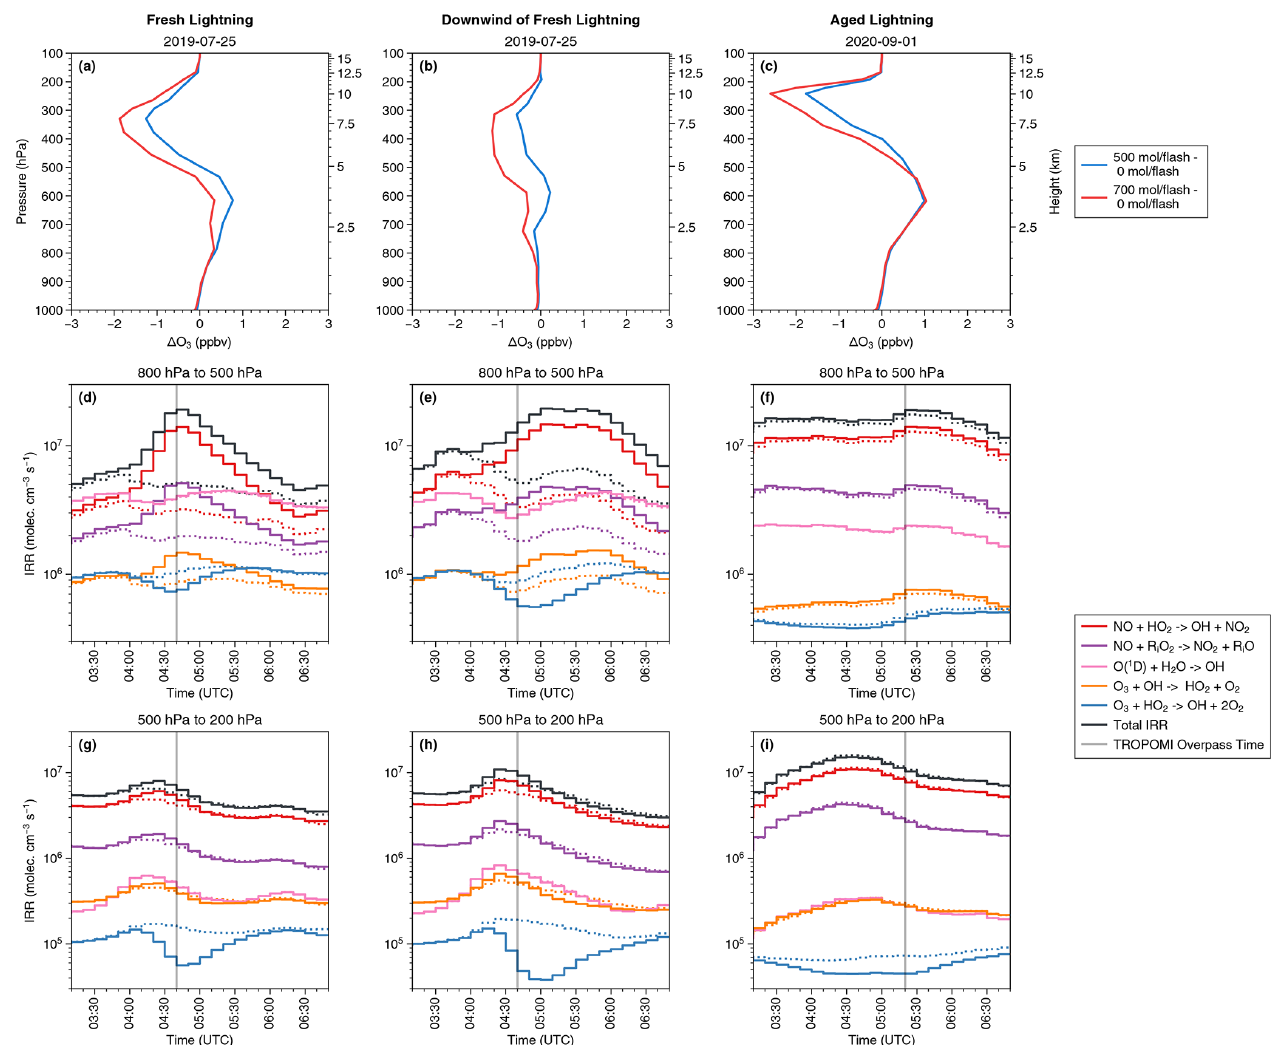
Figure 5. (a–c) Changes in O 3 profiles due to LNO x at TROPOMI overpass time in three regions (fresh lightning region, downwind of fresh lightning, and aged lightning area) as defined in Fig. 7. (d–f) Time series of the mean integrated reaction rate (IRR) between 800 and 500hPa. The legend shows detailed species and reactions. The “total IRR” is the O 3 loss IRR subtracted from the O 3 production IRR (red and purple lines). The solid line shows the IRR with LNO (500mol per flash), while the dashed line is without LNO. (g–i) Same as (d) – (f) but between 500 and